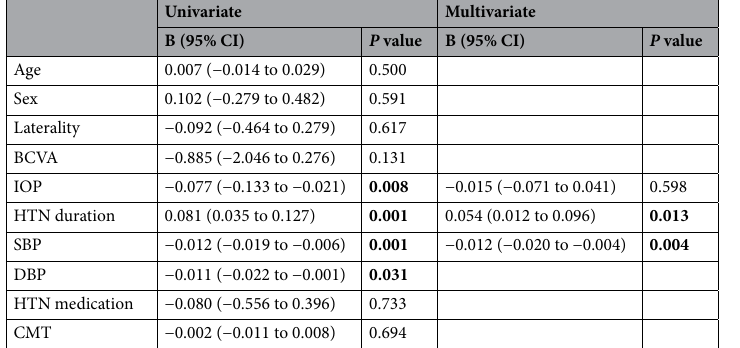
Table 4. Univariate and multivariate linear regression analyses for determining the factors associated with GC-IPL/VD ratio in patients with hypertensive retinopathy. BCVA best-corrected visual acuity, IOP intraocular pressure, HTN hypertension, SBP systolic pressure, DBP diastolic pressure, CMT central macular thickness. Values in boldface ( P < 0.050) are statistically significant.